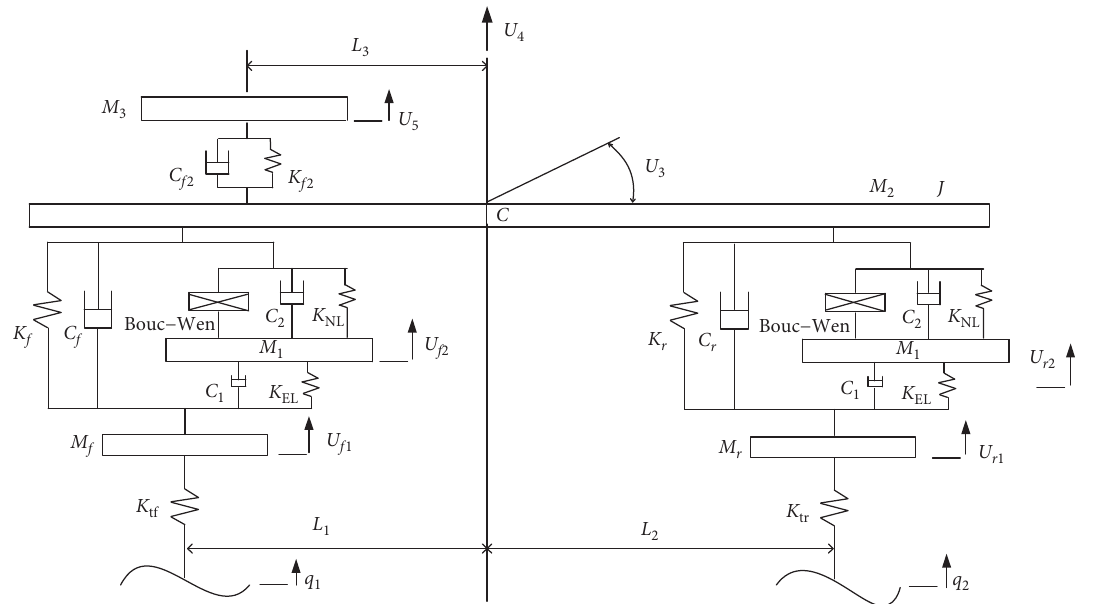
Figure 1: Half vehicle system coupling with the HNES